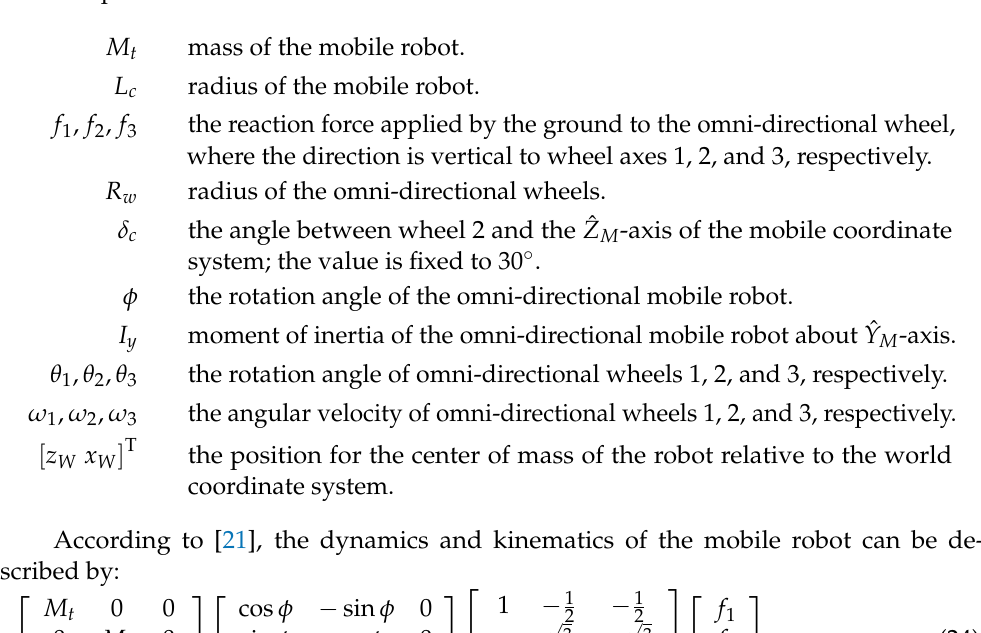
Figure 8. Top view of the omni-directional mobile robot. The parameters for an omni-directional mobile robot are listed as